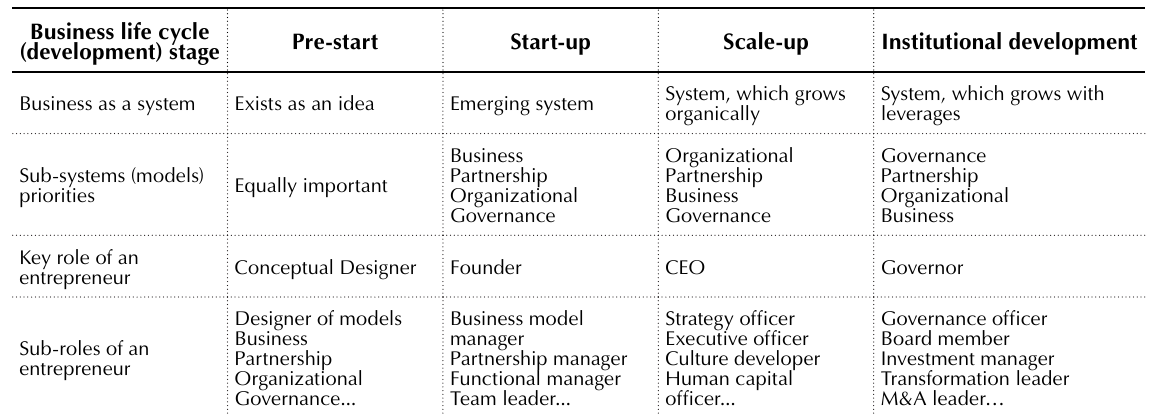
Table 1. A change model for entrepreneurial